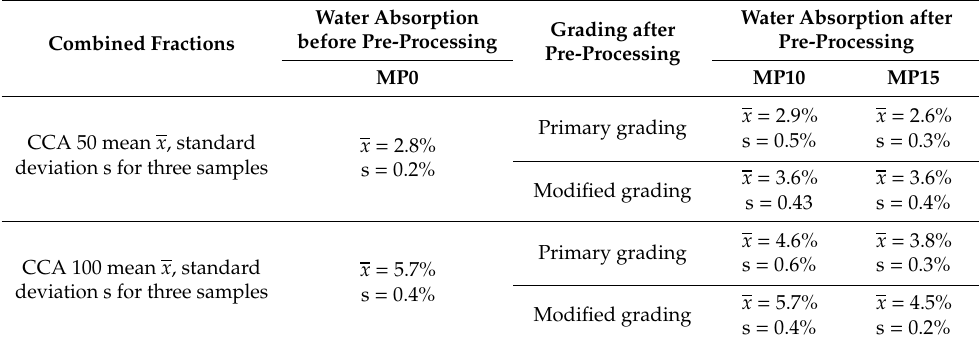
Table 5. Water absorption of combined CCA fractions before and after mechanical pre-processing Water Absorption Grading after before Pre-Processing Combined Fractions